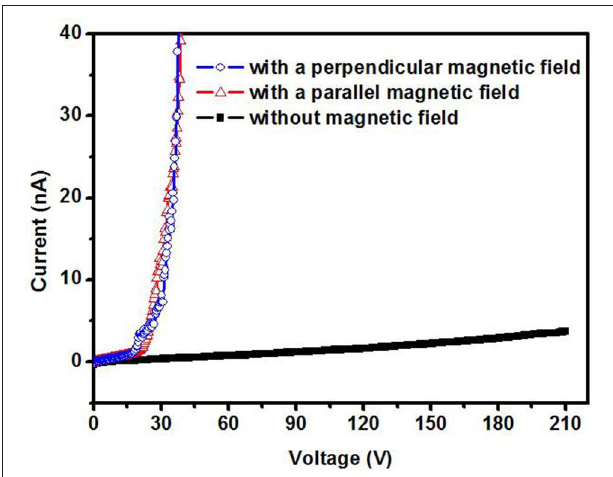
FIGURE 7 | Air ionization for ZnO nanorods electrode decorated with various Mn thickness under perpendicular magnetic field of 6,000 Gs.